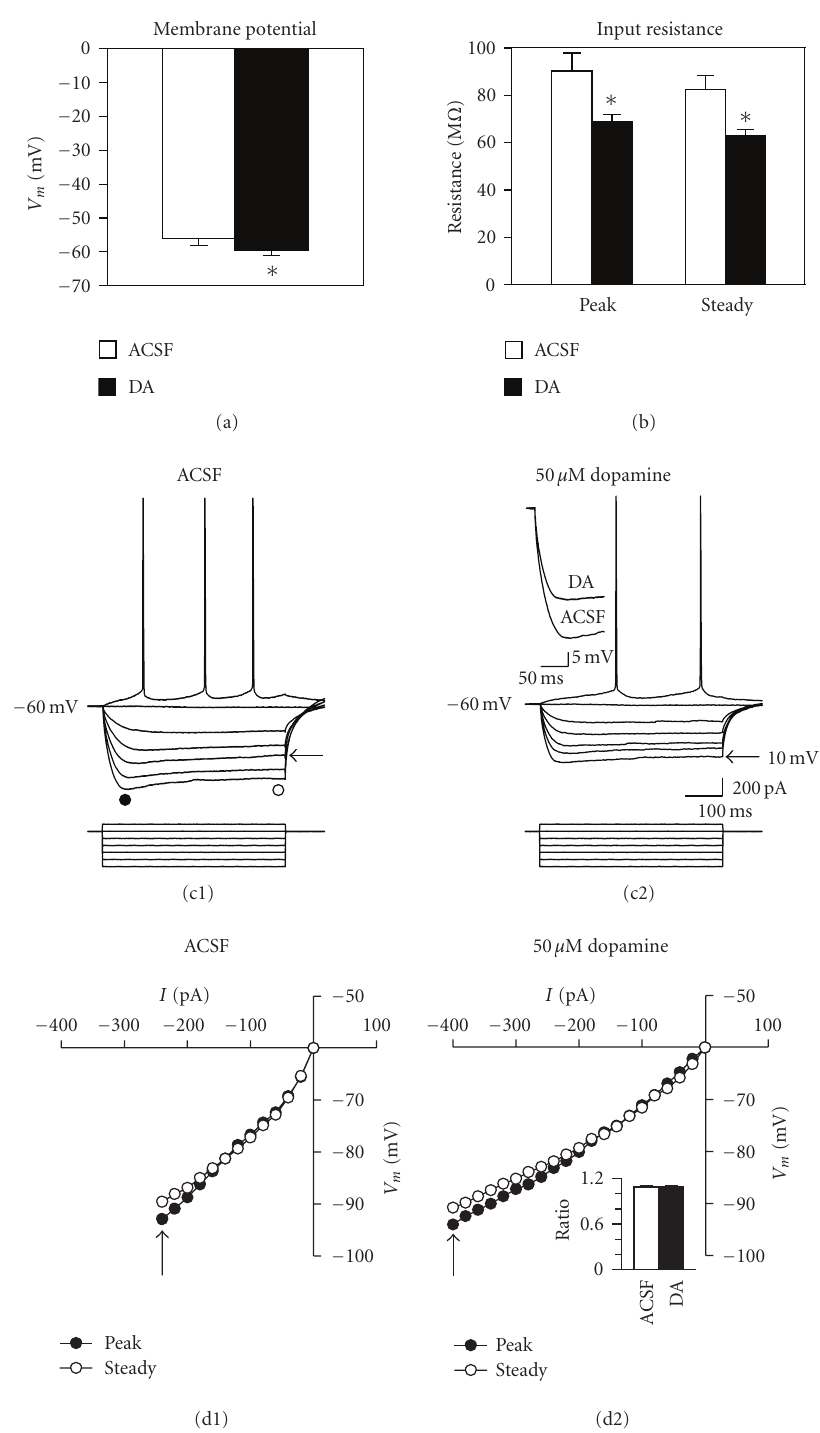
Figure 6: Dopamine hyperpolarizes membrane potential and reduces the input resistance of layer II fan cells. (a) Membrane potential was shifted to more hyperpolarized potentials by dopamine ( ∗ , P < . 001). (b) Dopamine also reduced both peak and steady-state input resistance ( ∗ , P < . 01). (c) Voltage responses to applied current steps before (c1) and after (c2) bath application of 50 μ M dopamine in a representative cell. Action potentials are truncated. Circles in (c1) indicate the latencies at which peak and steady-state input resistance were measured. Inset traces in (c2) compare the initial voltage deflection to a − 200 pA current step before and after application of dopamine. Arrows indicate voltage responses before and after dopamine that were similar in amplitude and which allow comparison of the magnitude of the inward rectification. Note also the reduced input resistance across the entire range of hyperpolarizing current pulses. (d) Current- voltage plots show peak and steady-state responses to current steps of increasing size. Arrows indicate points at which a comparable degree of inward rectification was observed during hyperpolarization to similar voltages before and after dopamine